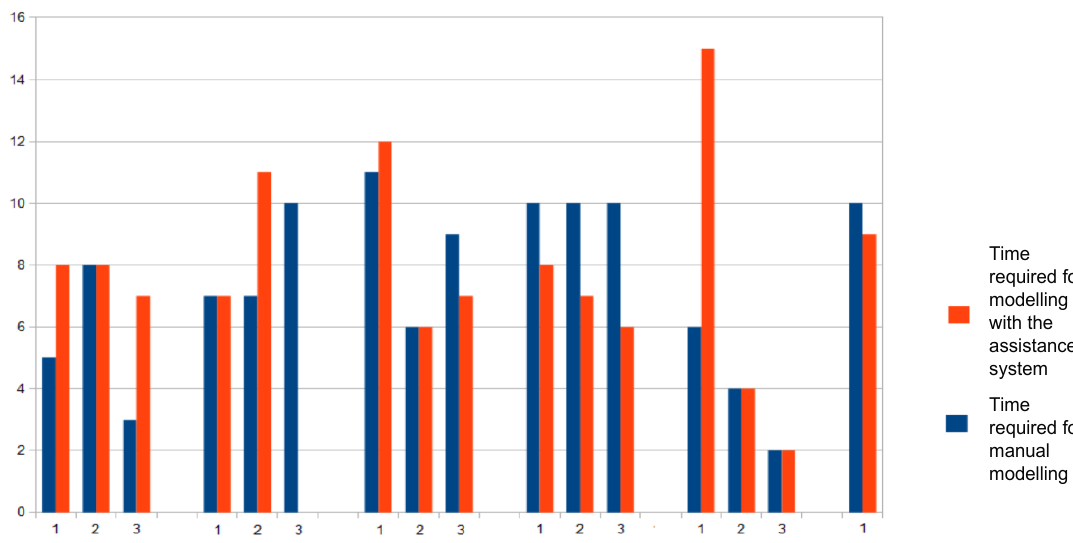
Figure 11. Assessing the time needed to create models with assistance and without